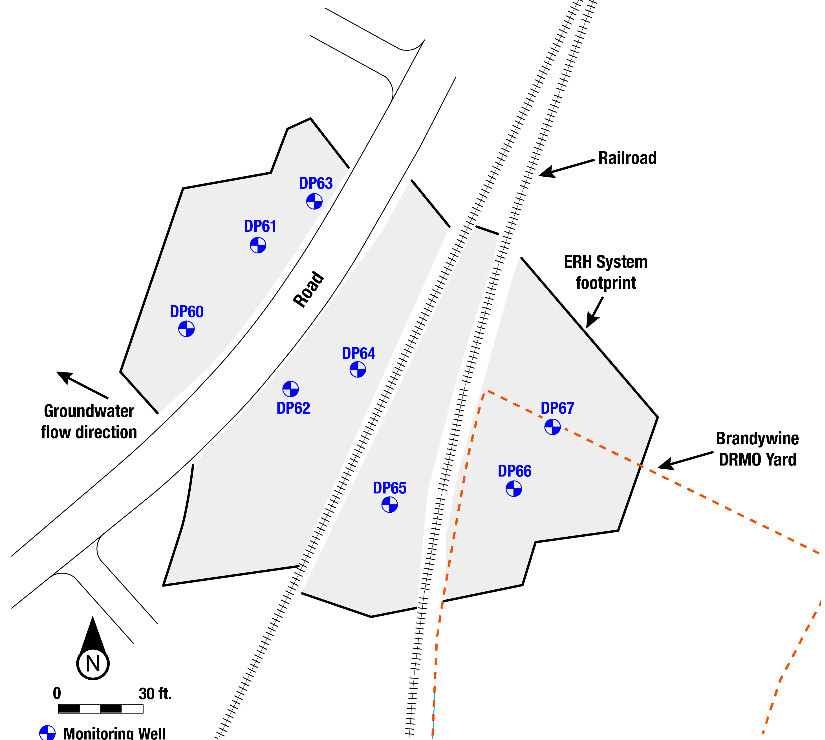
Figure 8. The Brandywine DRMO Yard with the ERH treatment footprint. Key surface features, groundwater flow direction, and location of monitoring wells are shown. All ERH vertical bored and sheet pile electrodes are located within the system footprint noted. Adapted from HGL [77].